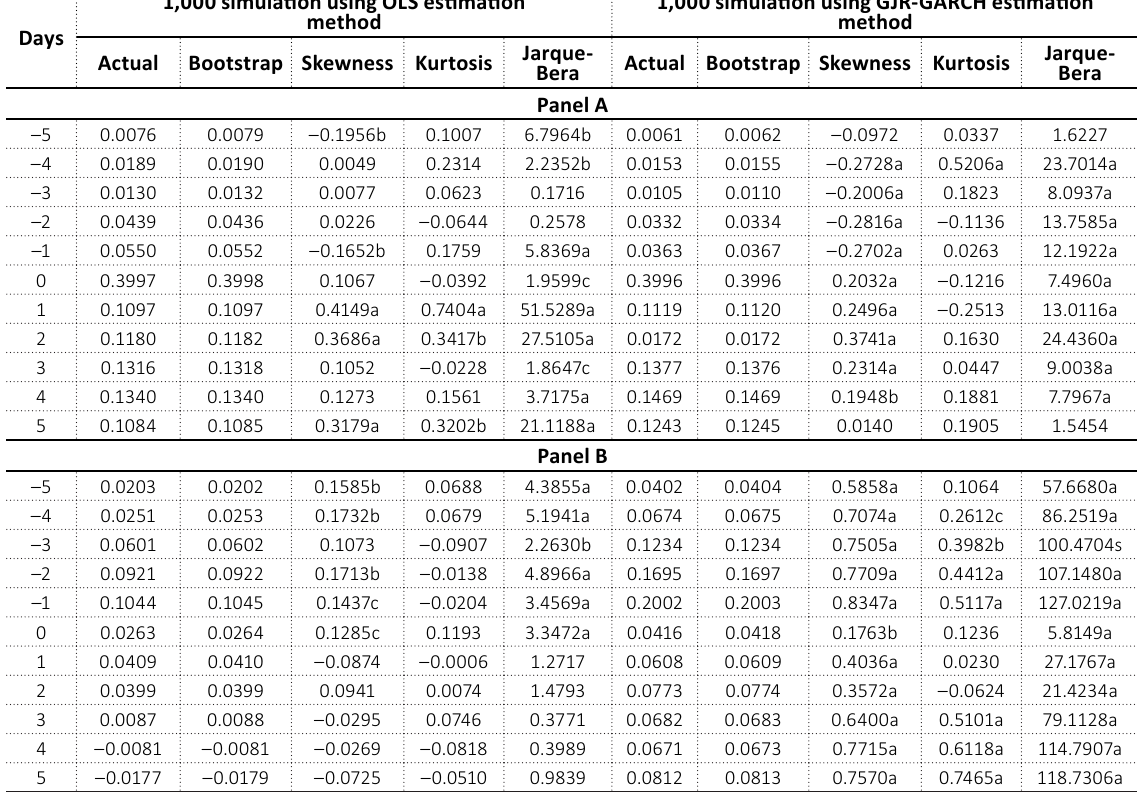
Table 1. Bootstrapping simulations of average cumulative measures for target and acquirer firms around merger